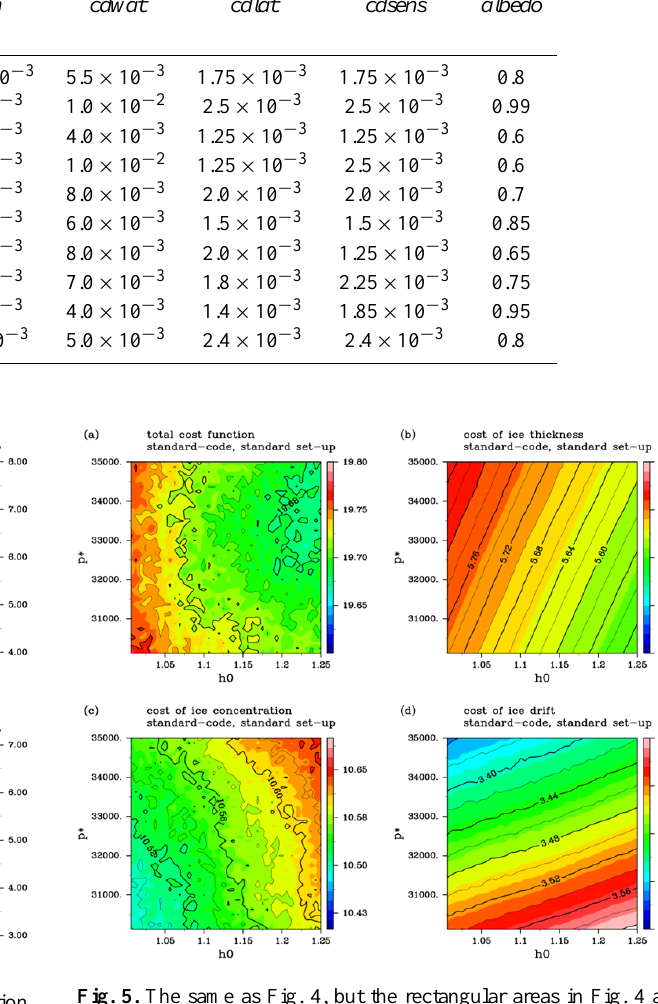
Fig. 5. The same as Fig. 4, but the rectangular areas in Fig. 4 are